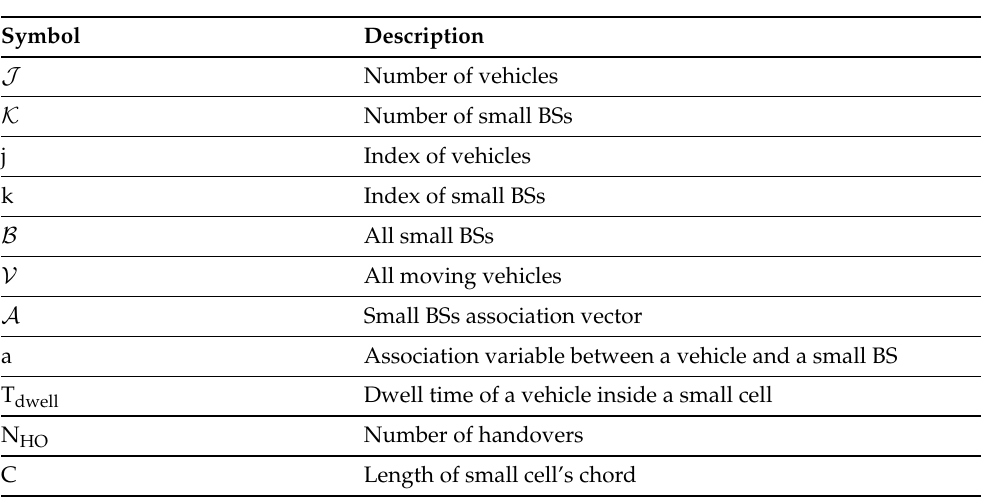
Table A2. List of main